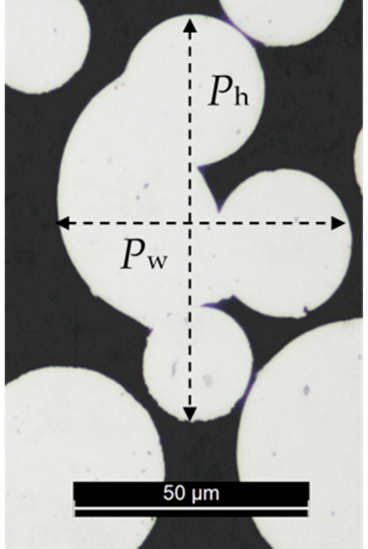
Figure 10. Coarse agglomerate particle captured by the 50 µ m